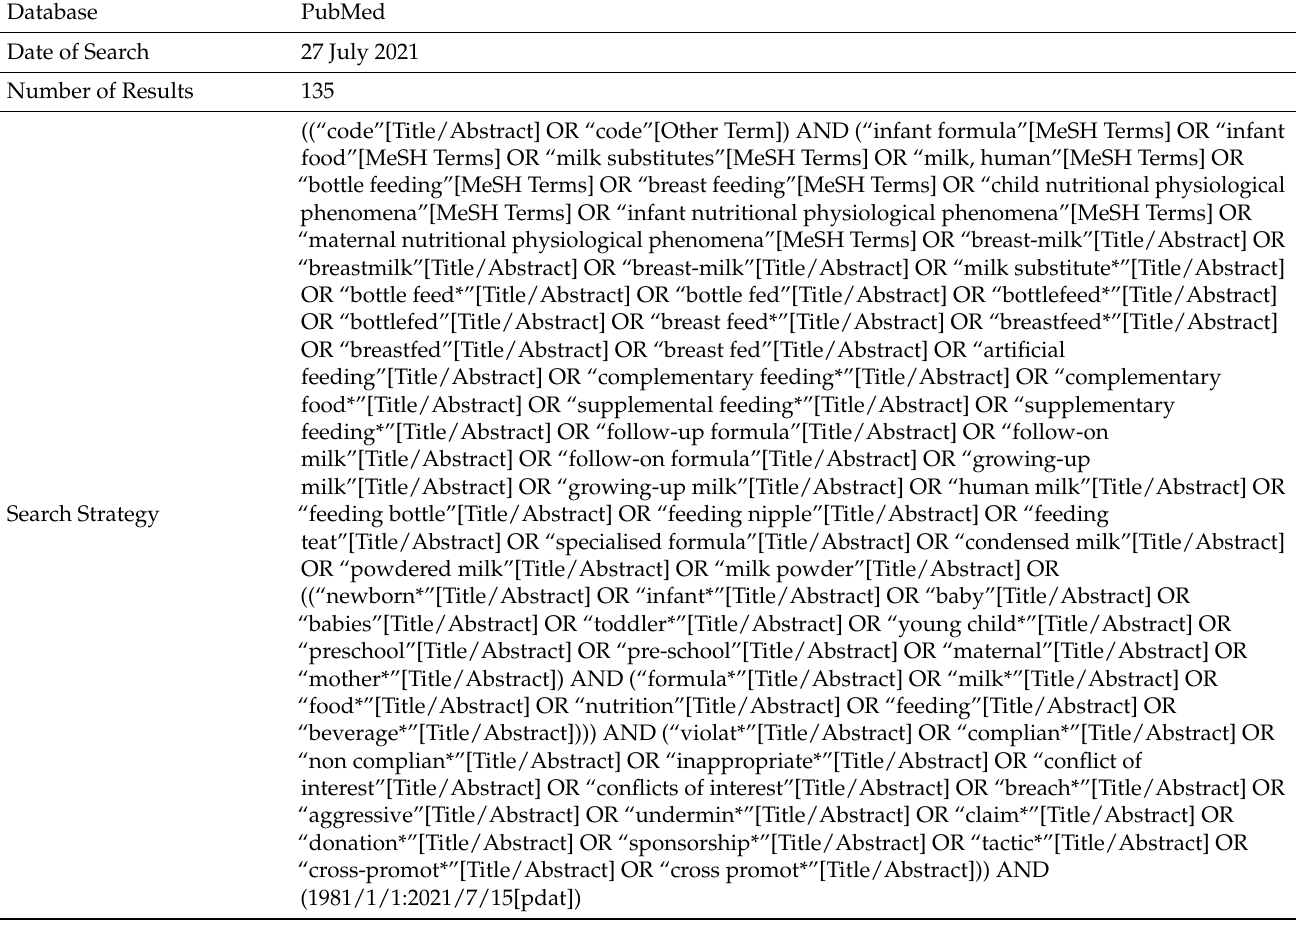
Table A2. Search terms piloted on PubMed.